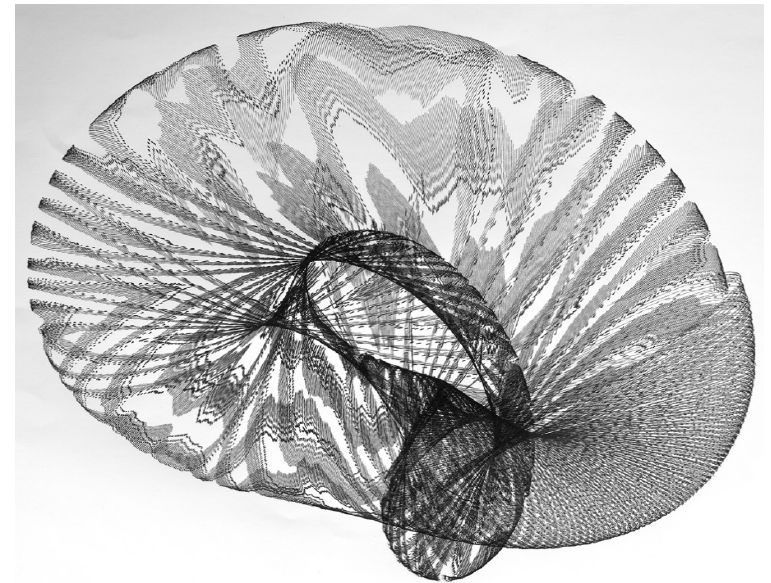
Figure 9. HHM drawing with pen ‐ lift in action.